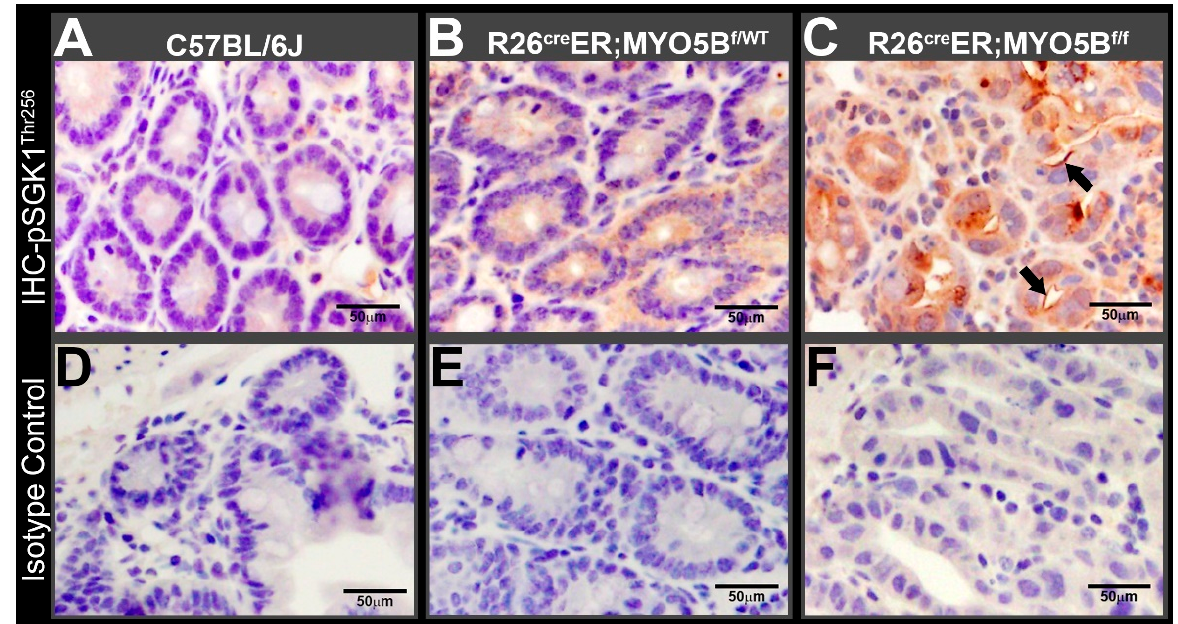
Figure 8. Phospho-SGK1 Thr256 is increased in tamoxifen (2 mg/day/mouse for 5 days)-treated R26 Cre ER;MYO5B f/f (Homozygous) mouse jejunum. Horseradish peroxidase staining detects pSGK1 Thr256 (arrows) in jejunal sections from paraffin-embedded blocks of ( A ) C57BL/6J (WT), ( B ) R26 Cre ER;MYO5B f/wt (Heterozygou s ), and ( C ) R26 Cre ER;MYO5B f/f (Homozygou s ) mice. ( D – F ) are isotype controls for negative staining of ( A – C ), respectively. Arrows are indicating pSGK1 Thr256 labeling. Nuclei are stained blue. Scale bars : 50 µm.